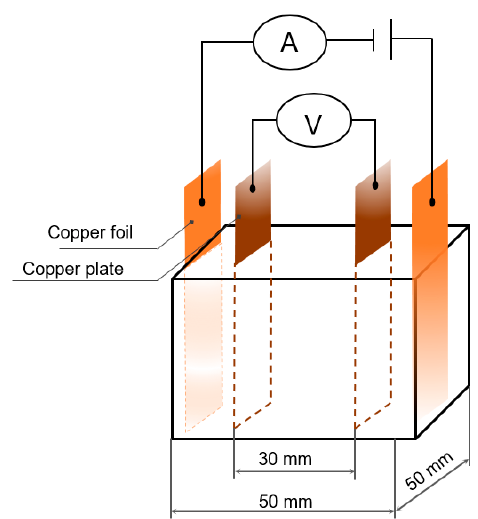
Figure 4. Sample and electrodes setup.